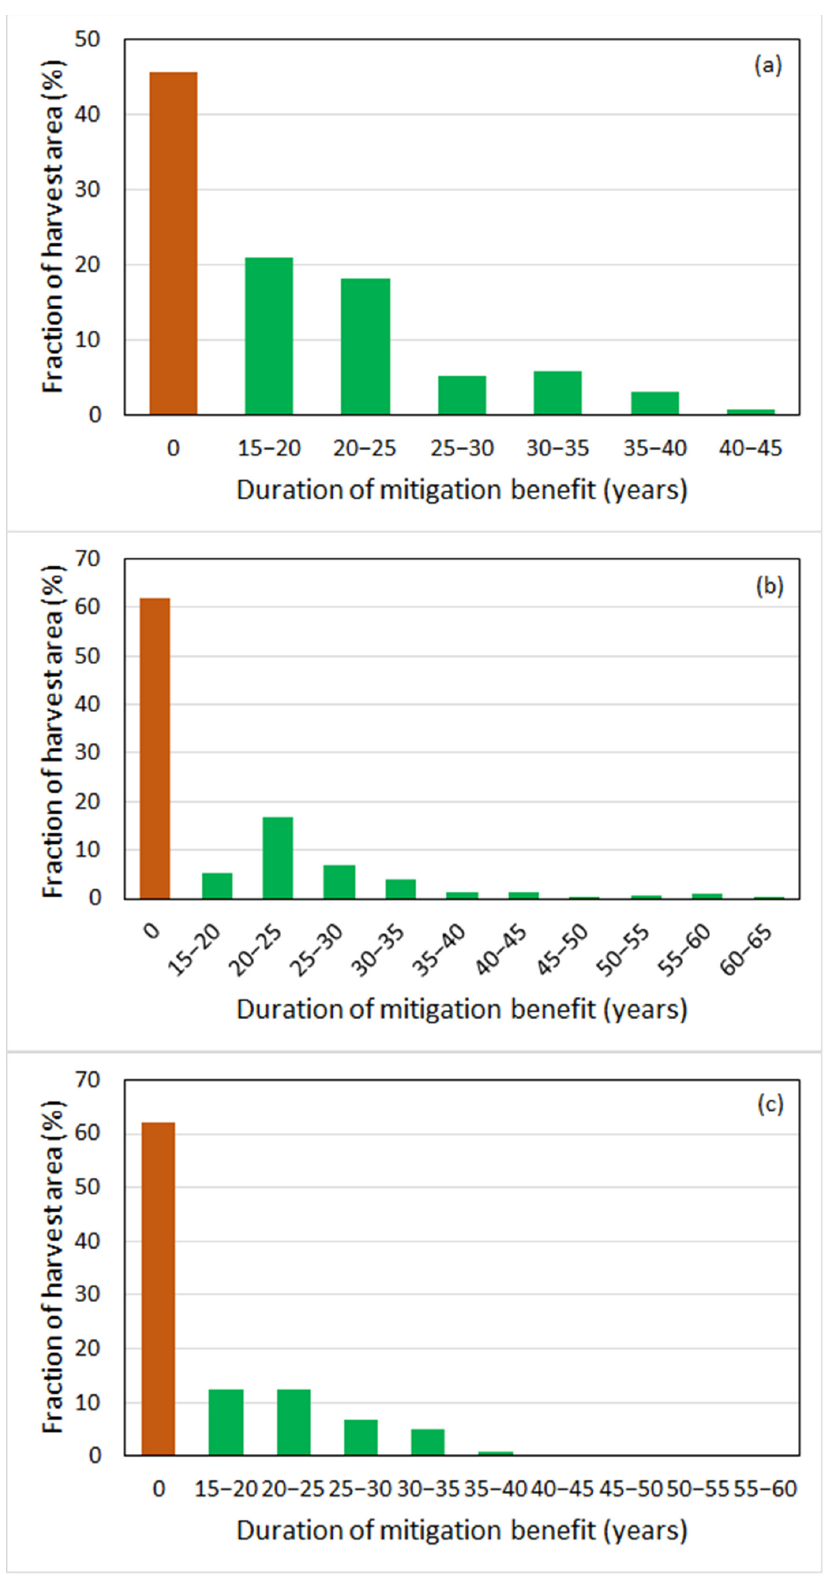
Figure 5. Fractions of annual available harvest area by the length of mitigation benefit from increasing harvest age by 10 years for ( a ) Hearst Forest, ( b ) Lakehead Forest, and ( c ) Pic River Forest management units in northwestern